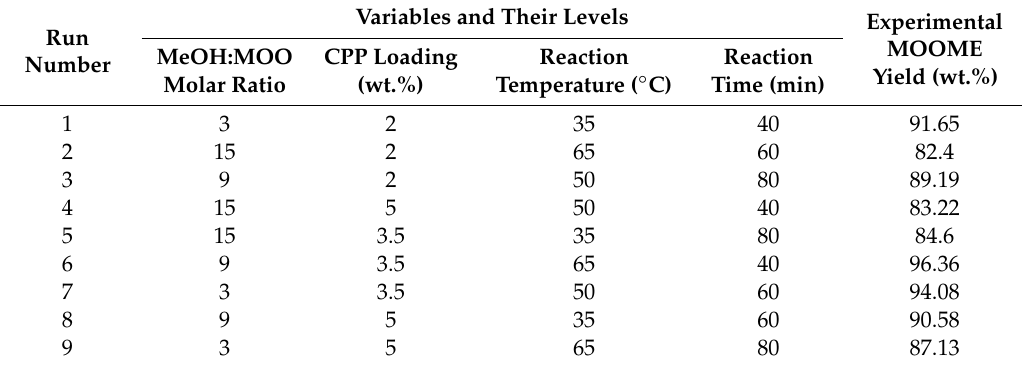
Table 1. Experimental design matrix generated by L 9 orthogonal array with MOOME